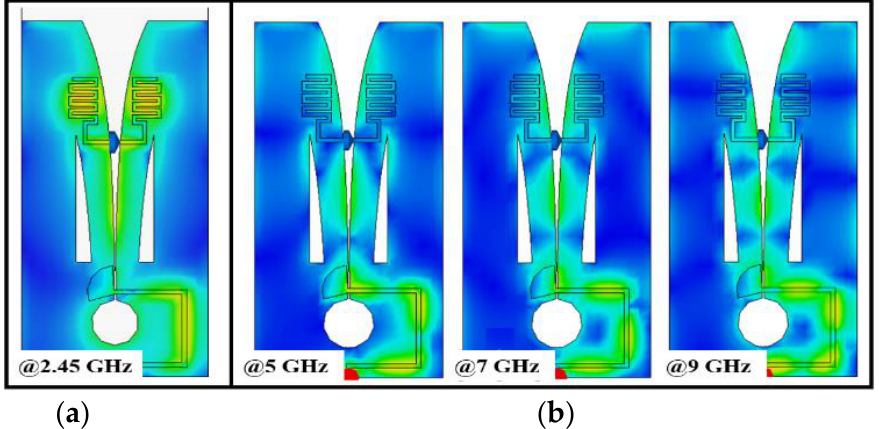
Figure 11. Simulated current distributions: ( a ) resonance mode at 2.45 GHz with the PIN diode in the ON state and ( b ) traveling-wave mode at 5, 7, and 9 GHz with the PIN diode in the OFF state. Table 2. Comparison with existing work.